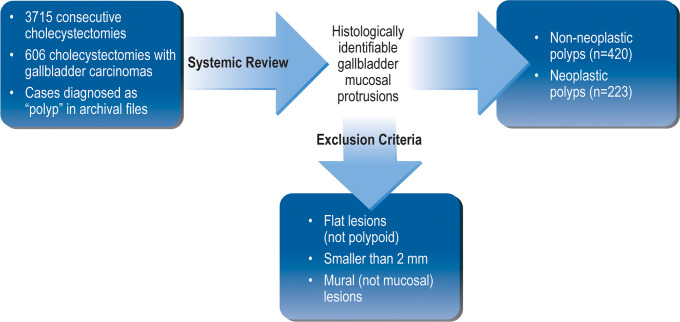
The flowchart summarized inclusion and exclusion criteria.